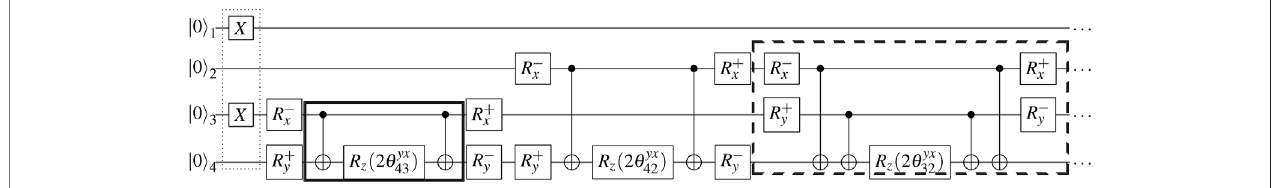
FIGURE 2 | Circuit showing the fi rst three parameters for a four-qubit XY-ansatz. The R + x , R − x , and R + y , R − y gates are R x ( π /2), R x ( − π /2), and R y ( π /2), R y ( − π /2), respectively. The parameterized gate is always placed on the last qubit. Gates in the solid box correspond to the e − i θσ z · σ z operator. Gates in the dashed box implement e − i θσ y · σ x · σ z . The shown circuit is unoptimized and is optimized before usage.